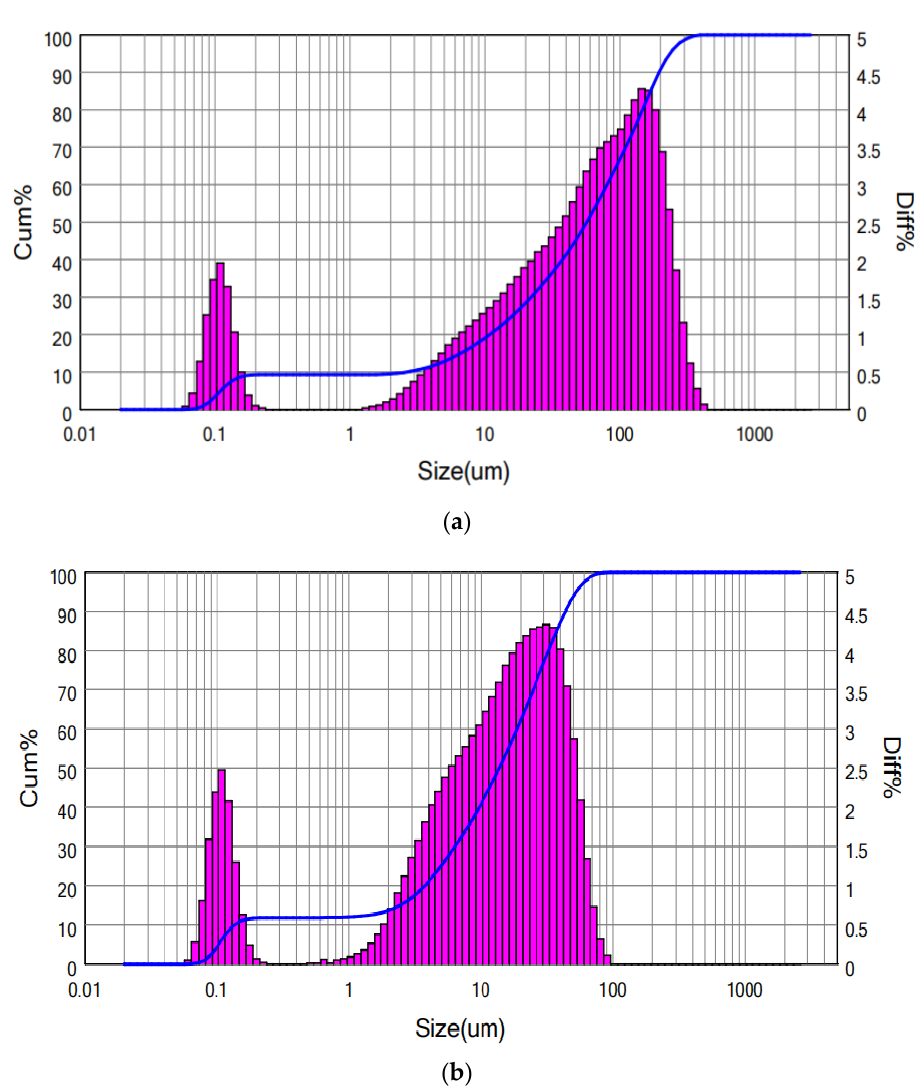
Figure 1. Particle size distribution graphs for ( a ) ultrasonically prepared and ( b ) conventionally prepared NiFe 2 O 4 catalysts at 5 wt% Ni loading.